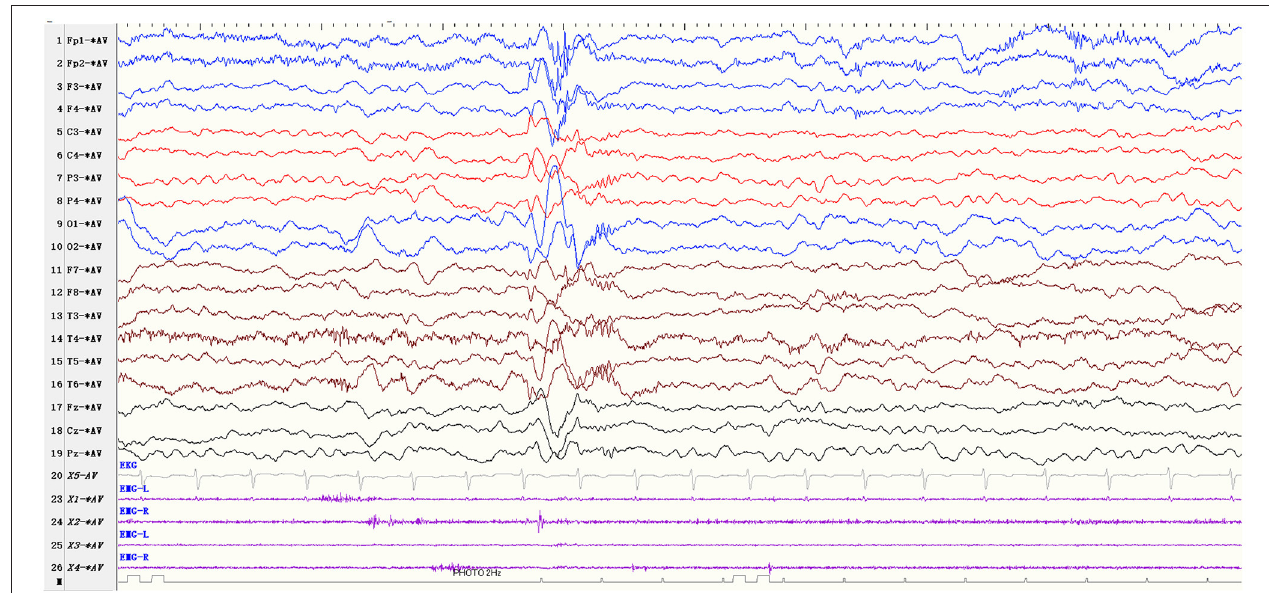
FIGURE 1 | EEG parameters: sensitivity 10 µ V/mm, high-frequency filter 70Hz, low-frequency filter 0.5Hz Visual stimulus-induced ES (patients 15). The patient showed ES due to the sudden unexpected flash stimulus, and the ictal EEG showed generalized 1–2Hz medium-high amplitude polyphasic slow-waves and 16–20Hz low amplitude fast